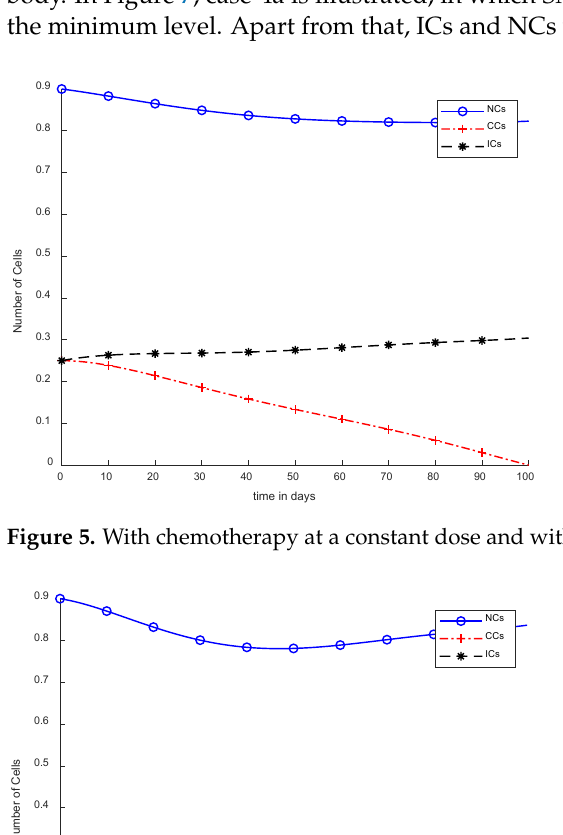
Figure 4. Without chemotherapy and controllers.